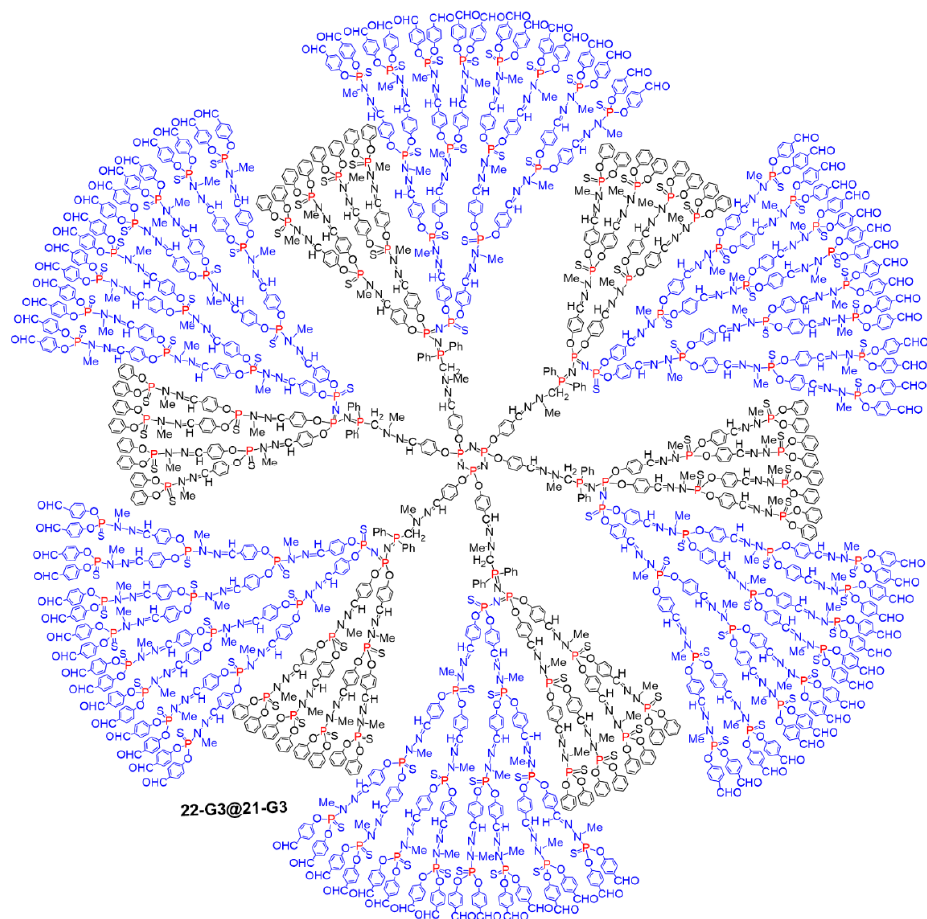
Figure 14. Full structure of dendrimer 22-G3@21-G3 . The newly synthesized branches are represented in blue.